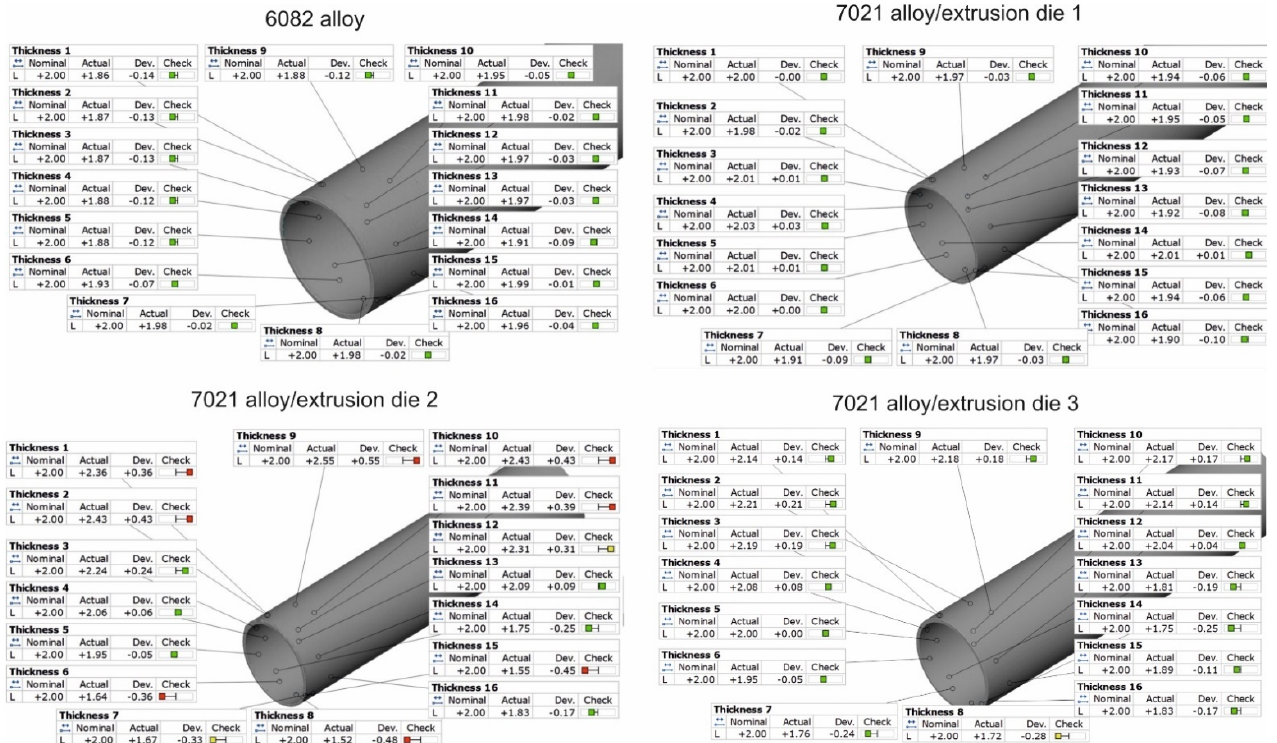
Figure 16. Results of optical scanning of the tubes of Ø50 × 2 mm: measured wall thickness of tubes extruded from 6082 alloy by using 4-hole die (on the top left) and extruded from 7021 alloy by using 2-hole die 1 (on the top right), 2-hole die 2 (on the bottom left), as well as extruded from 7021 alloy by using 2-hole die 3 (at the bottom right).